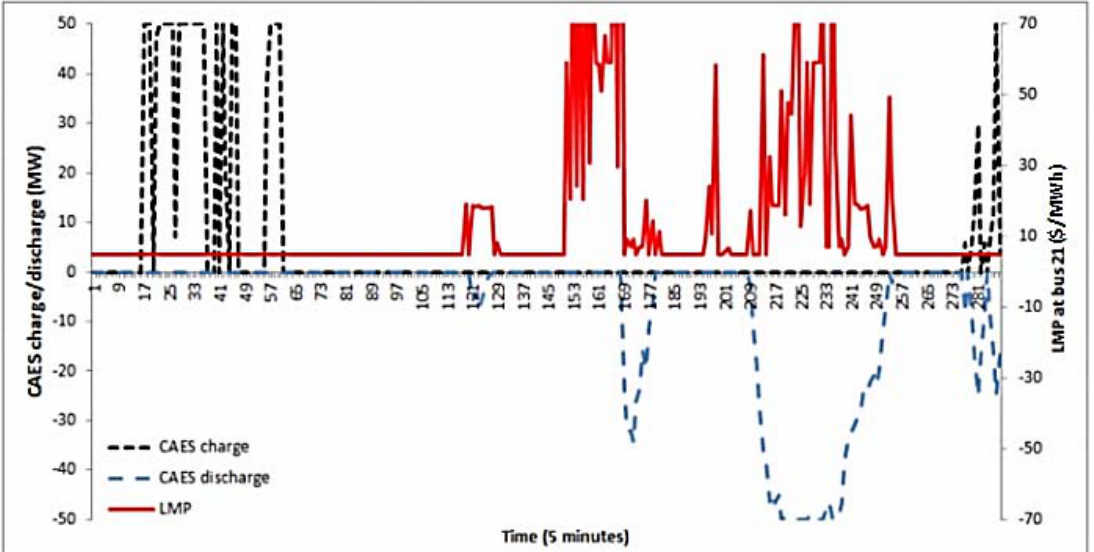
Figure 7. CAES RT charge/discharge values and RT LMPs at bus 21 under scenario